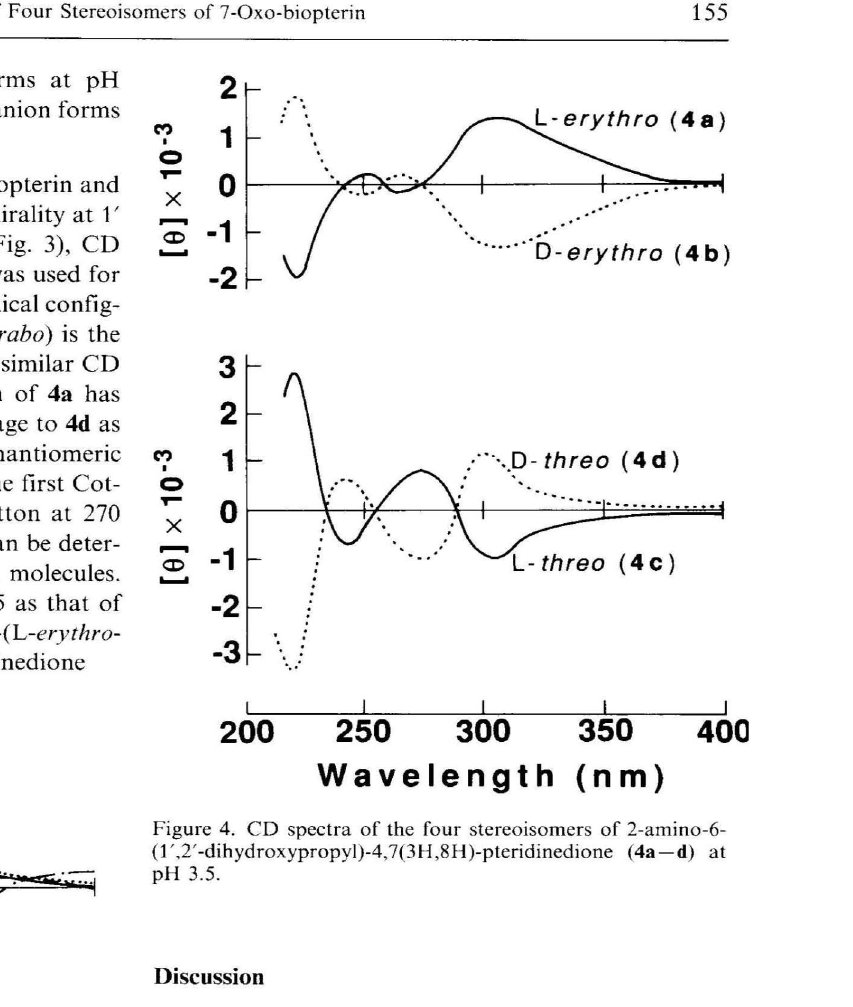
Figure 4. CD spectra of the four stereoisomers of 2-amino-6- (1',2' -dihydroxypropyl)-4,7(3H,SH)-pteridinedione (43 -d)